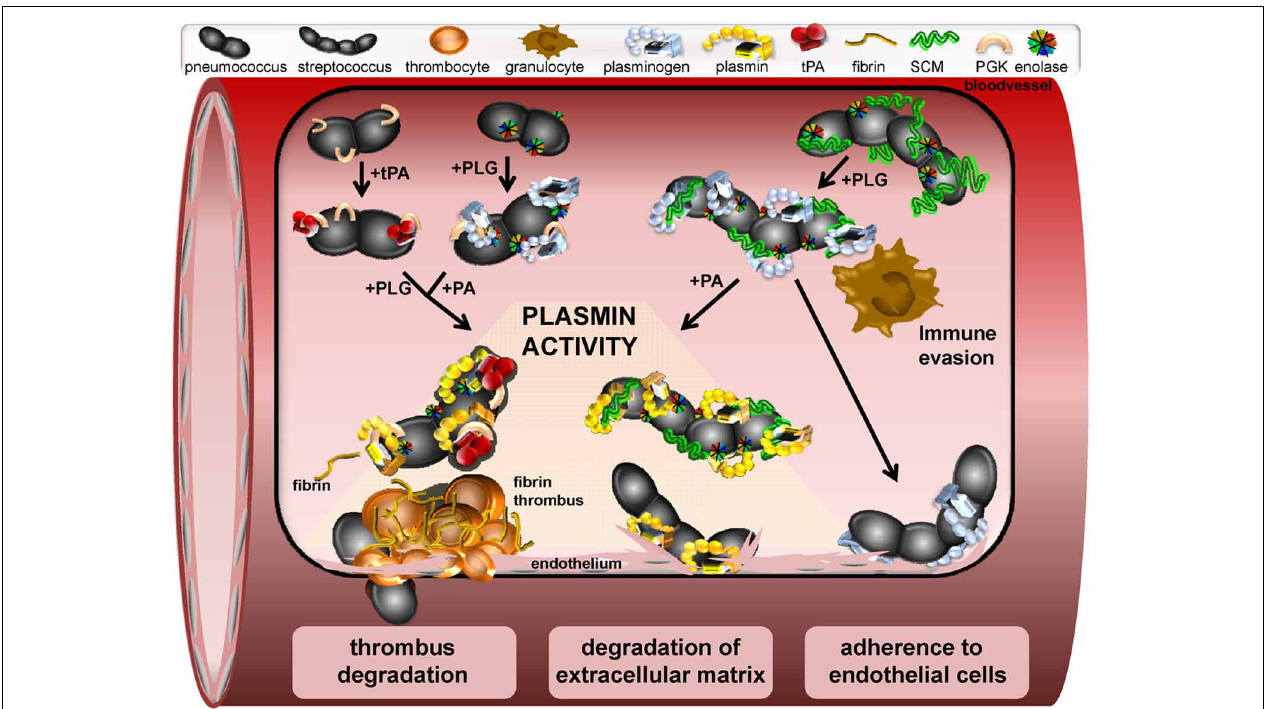
FIGURE 1 | Schematic model of a window section through a microvessel, presenting different functional mechanisms induced by interaction of streptococci with plasminogen and plasmin. In the upper left site, binding of tPA to the pneumococcal PGK and binding of PLG to surface displayed moonlighting proteins is shown. Subsequent recruitment of PLG and a plasminogen activator leads to generation of plasmin activity on the bacterial surface. Similarly, PLG binding to streptococcal M-and M-like-proteins is followed by activation